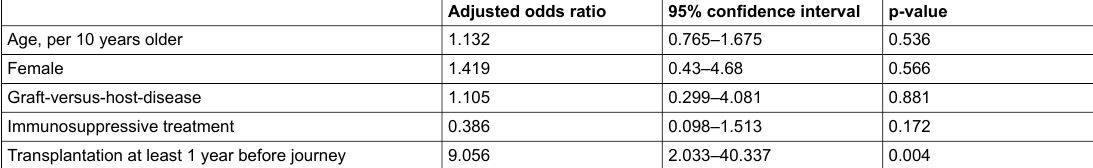
Table 3: Multivariate regression analysis of possible predictors for travel activity in 153 patients after allogeneic haematopoietic stem cell transplantation.